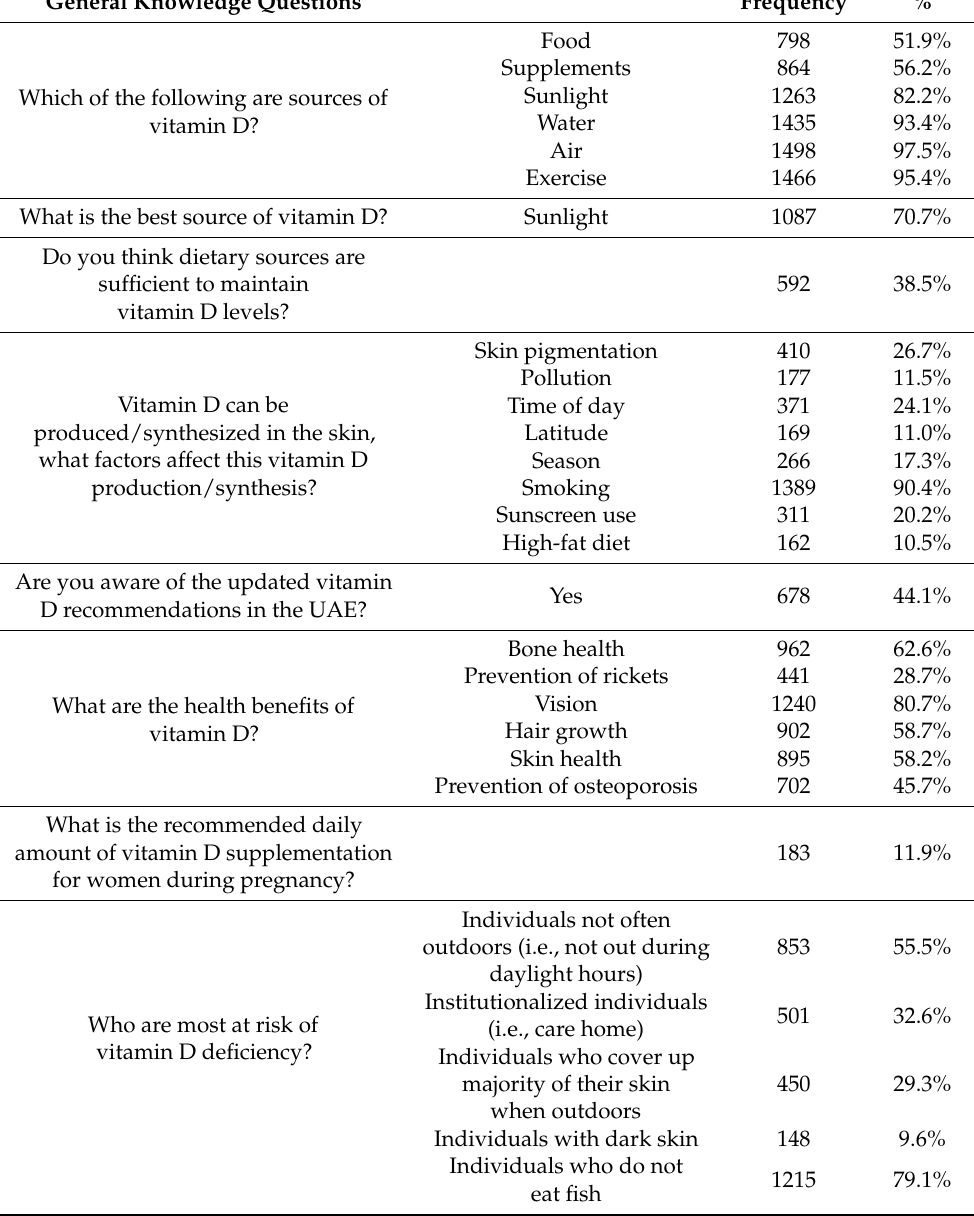
Table A1. General knowledge of vitamin D ( n = 1537)—Individual